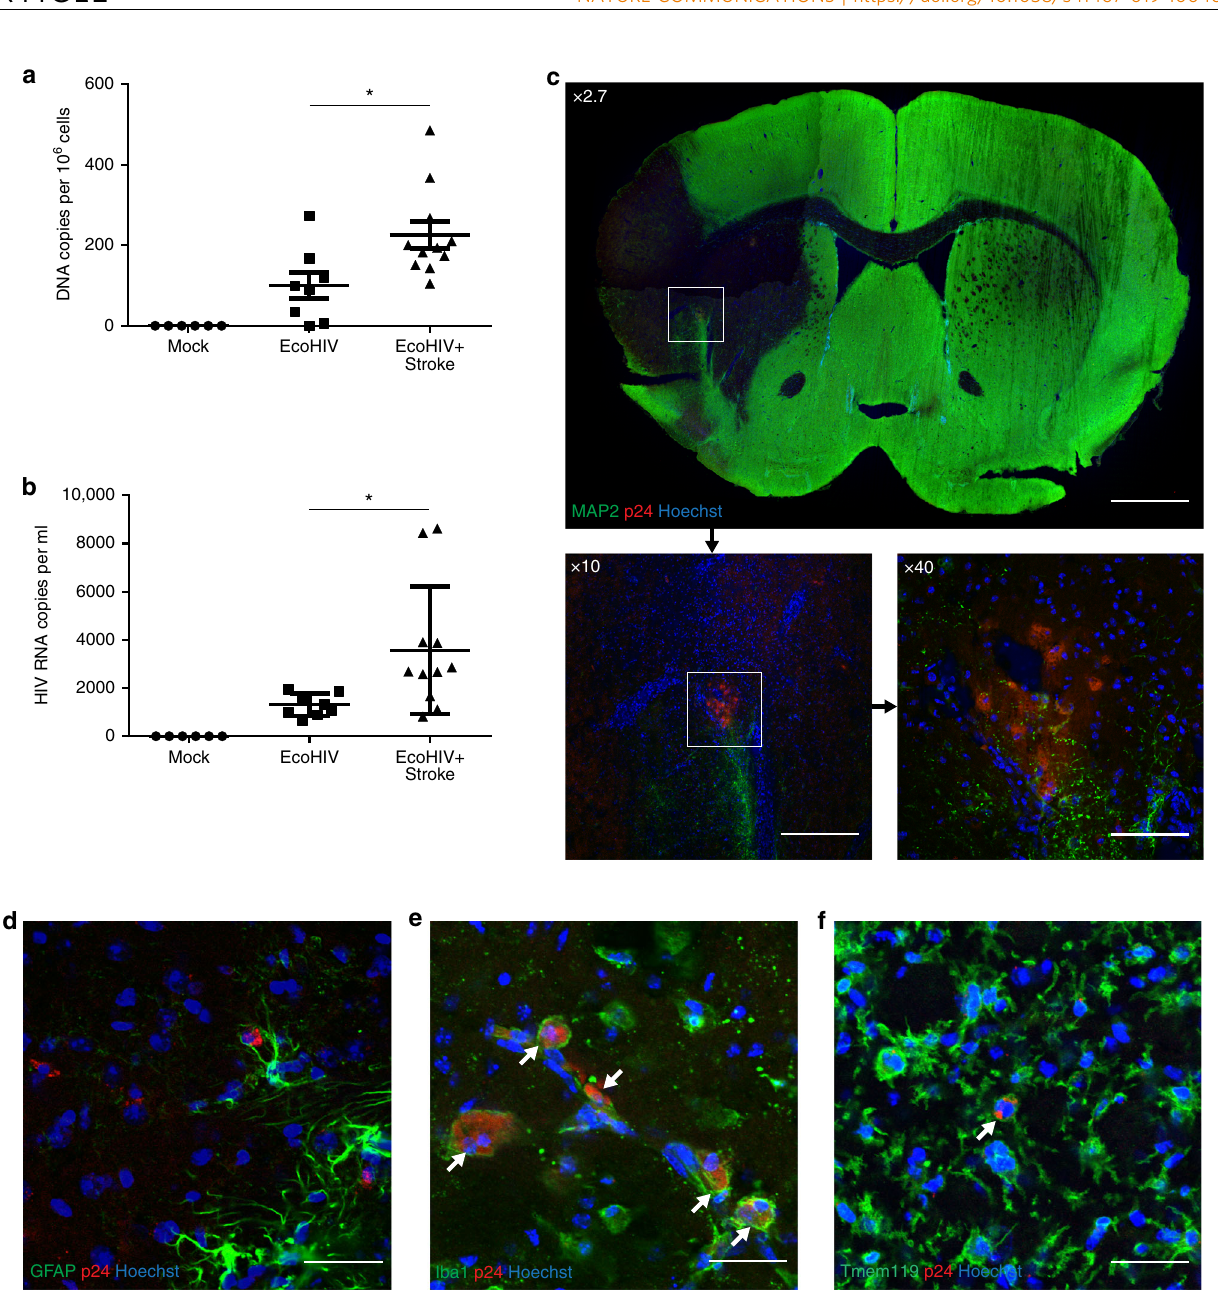
Fig. 5 Ischemic stroke results in increased CNS viral load. Mice were infected with EcoHIV and subjected to stroke as in Fig. 1. a Analysis of EcoHIV DNA genome copies in the ipsilateral hemisphere in mock-infected and EcoHIV-infected mice at day 0 (before stroke) and day 7 post-stroke; n = 6 – 11 mice per group, 2 independent experiments. b Quanti fi cation of serum viral RNA genome copies in the same mice as in ( a ); n = 6 – 11 mice per group, 2 independent experiments. c Brain sections stained for MAP2 (neurons), p24 (HIV marker), and Hoechst (nuclei). Dark area denotes infarct area; scale bar 1 mm. Enlargements (10 × , scale bar 320 µ m; and 40 × , scale bar 80 µ m) of the area with cells positive for HIV p24. In addition, sections were stained with p24 antibody and cell-speci fi c markers to determine the cell type harboring HIV, GFAP (astrocytes, d ; scale bar 20 µ m), lba1 (monocyte/macrophages/ microglia, e ; scale bar 20 µ m), and Tmem119 (microglia, f ; scale bar 20 µ m). Double-stained cells are indicated by arrows. Data presented as mean and SEM with individual data points. Source data are provided as a Source Data fi le. * p < 0.05 vs EcoHIV; unpaired t